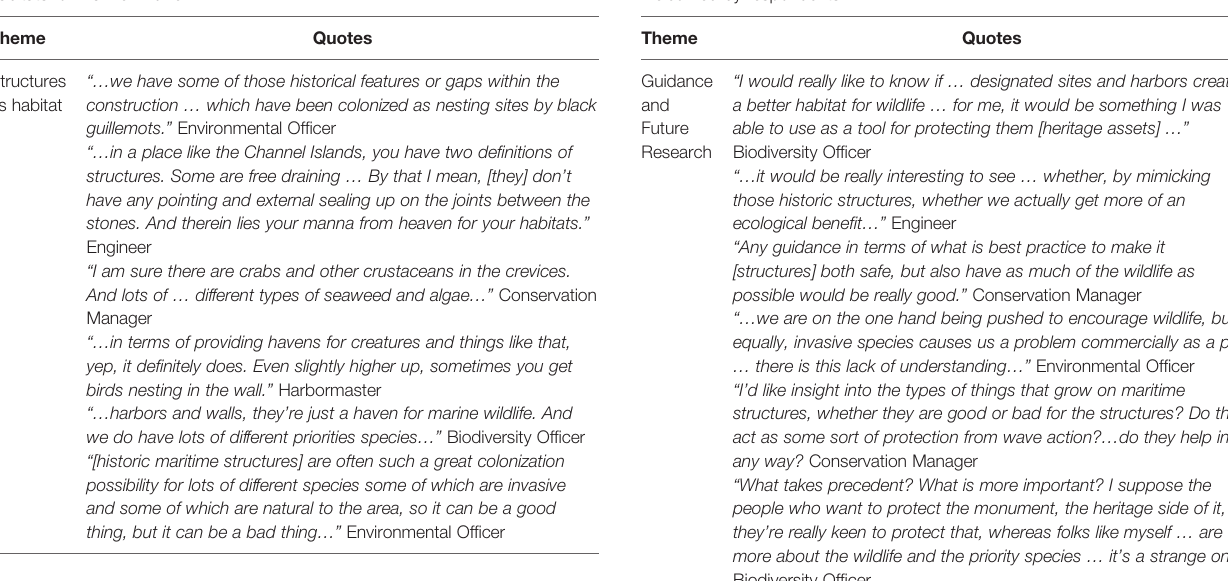
TABLE 10 | Quotes illustrating the perception that historic structures provide habitats for marine wildlife.